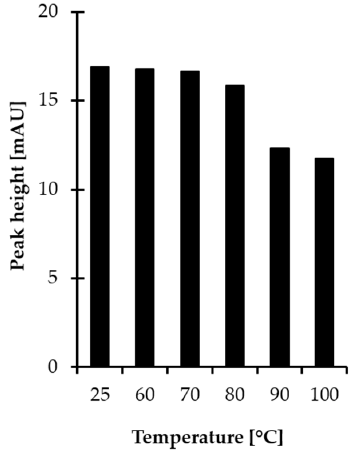
Figure2. InfluenceoftemperatureonHPPTCAstability, expressedasapeakheightofHPPTCA.Samples were assayed according to a previously published procedure based on HPLC-UV measurements